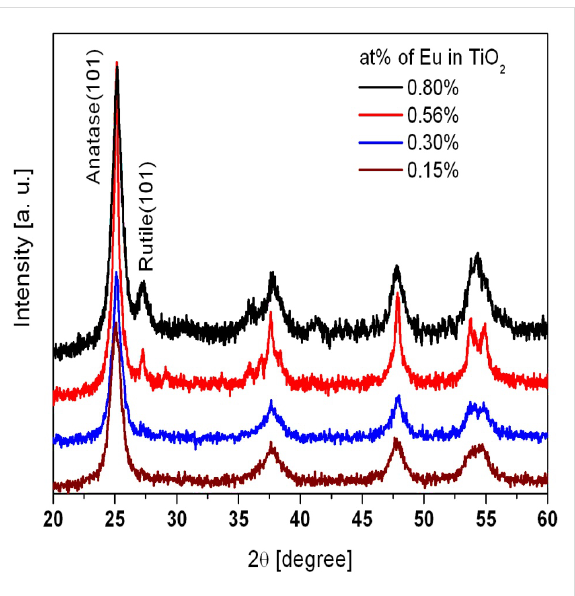
Figure 2: X-ray diffraction patterns (Cu K α radiation) from the TiO 2 :Eu nanophosphors produced by the CVR method. For low Eu concentra- tions, only the anatase phase is found, whereas for higher concentra- tions a mixture of anatase and rutile can be observed.